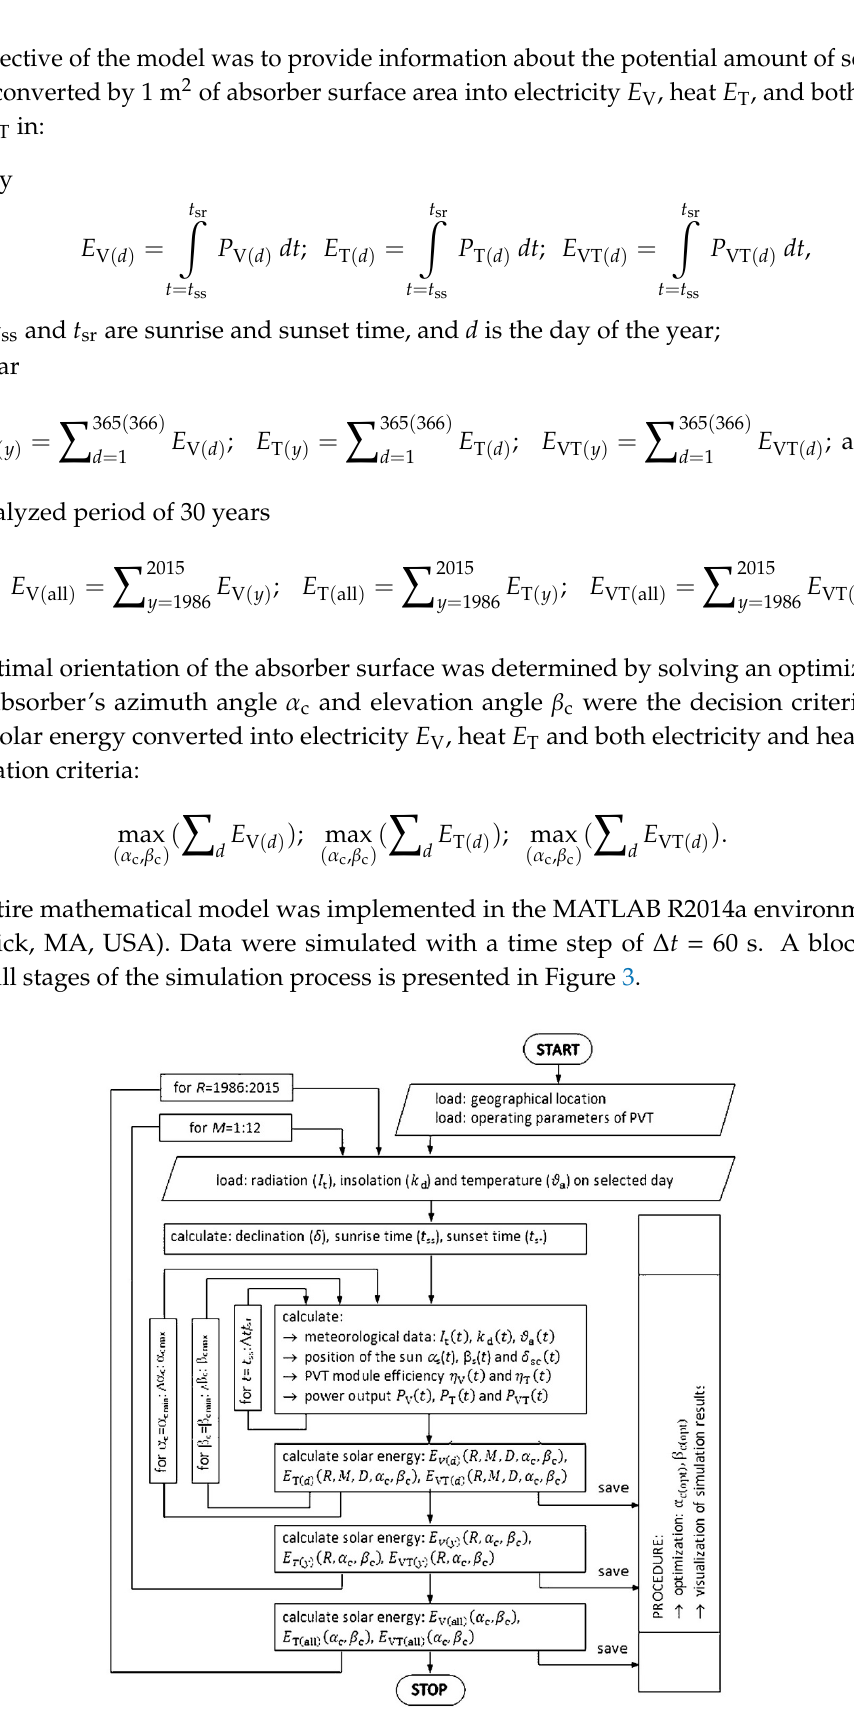
Figure 3. Flowchart for calculating fixed surfaces throughout the year.